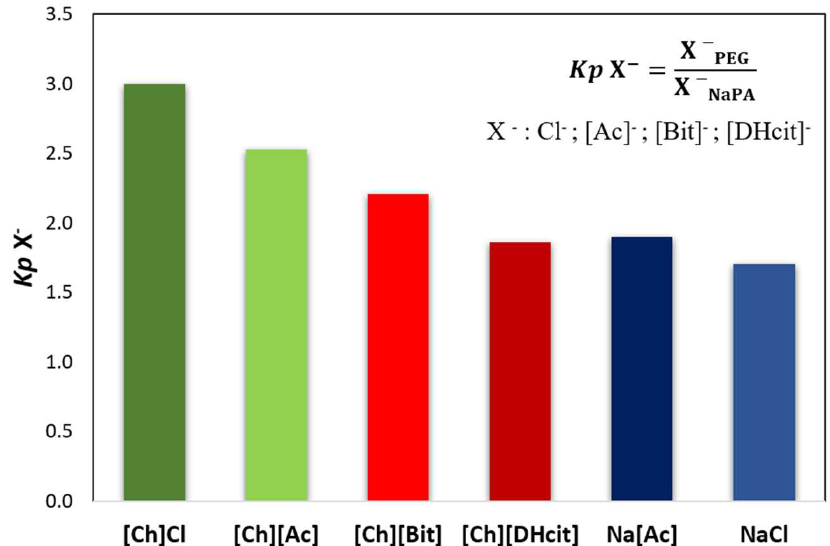
Figure 4. Anion partition coefficients ( Kp X − ), between the PEG-rich ( top ) phase and NaPA-rich ( bottom ) phase determined for the systems composed of PEG 600 + NaPA 8000 + water + 10 wt% of electrolytes, whereas X − corresponds to chloride (Cl − ), acetate ([Ac] − ), bitartrate ([Bit] − ) and dihydrogencitrate ([DHcit] − ) anions of the added electrolytes.